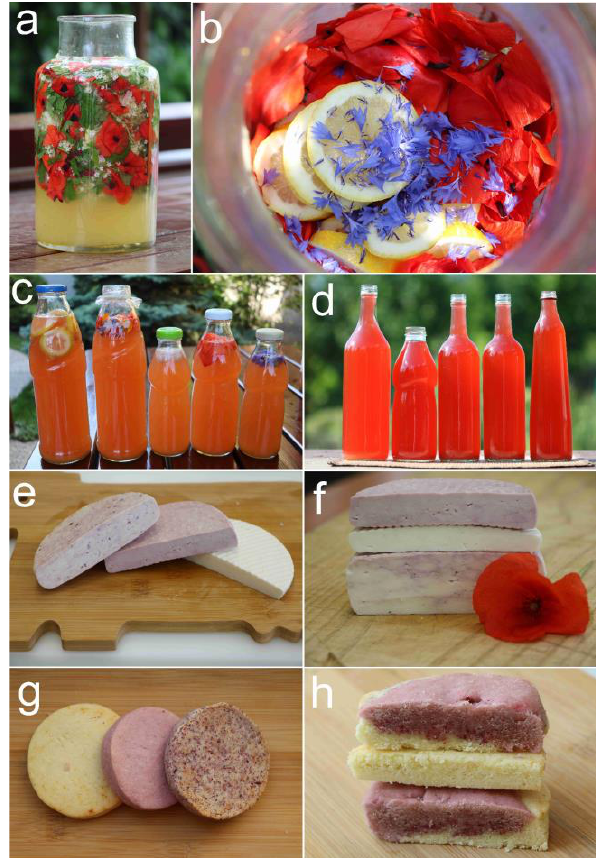
Figure 3. Food applications of the studied species, including poppy petals and cornflower flowers, used to dye and decorate homemade black elder ( Sambucus nigra L.) syrup ( a – d ); handcrafted cheese ( e , f ); and cakes ( g , h ) coloured using poppy petals and petal extracts (Photographs by Gyula Pinke).